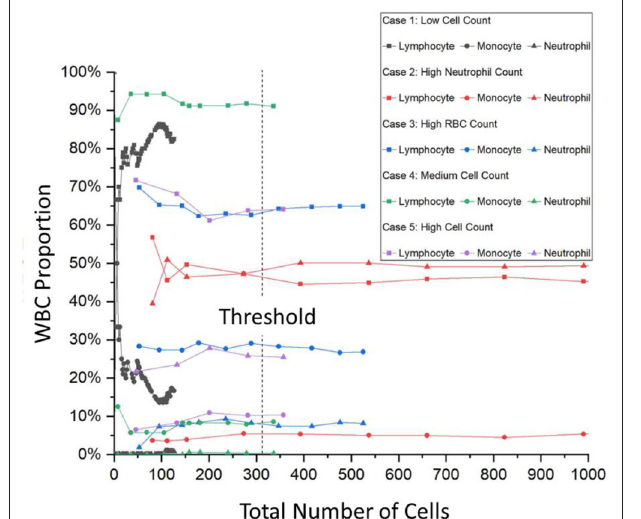
FIGURE 2 | A trend graph of the number of cells per patient needed for certain patient condition examples. It can be seen that after a certain amount of cells, the percentage of the WBC type saturates thus determining the number of cells needed for a successful and accurate hospital report. This trend graph shows that on average, 315 cells are needed with even the onset of saturation starting at around 150 cells. WBC, white blood cells.